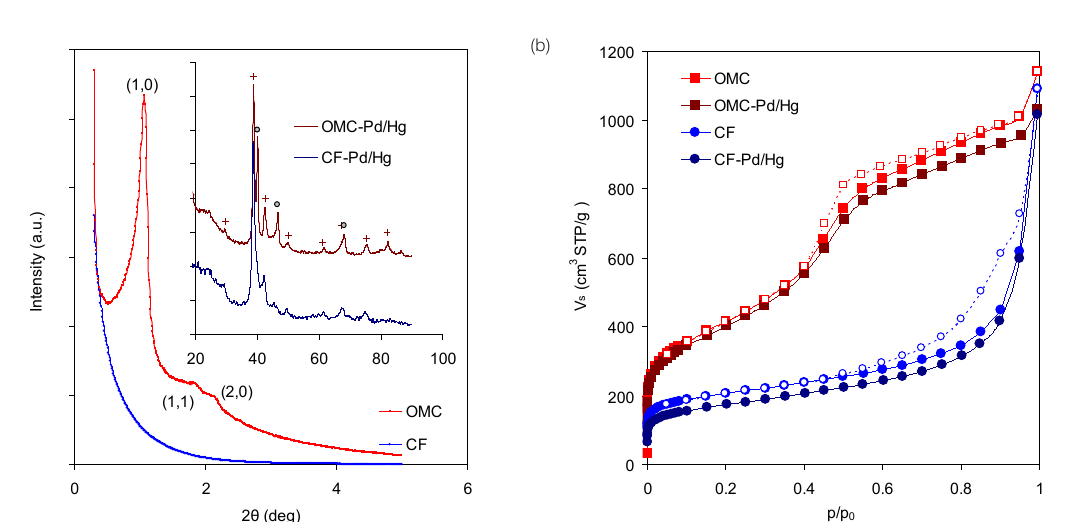
Figure 1. (a) Low angle XRD spectra of CF and OMC. Inset: XRD of the doped analogues. Potarite (crosses): (100), (101), (110), (111), (200), (201), (211), (202), Pd (circles): (111), (200), (220). (b) N (77 K) sorption-desorption isotherms (desorption: dotted lines-open symbols. 2 Desorption branches for the doped materials have been omitted for clarity).